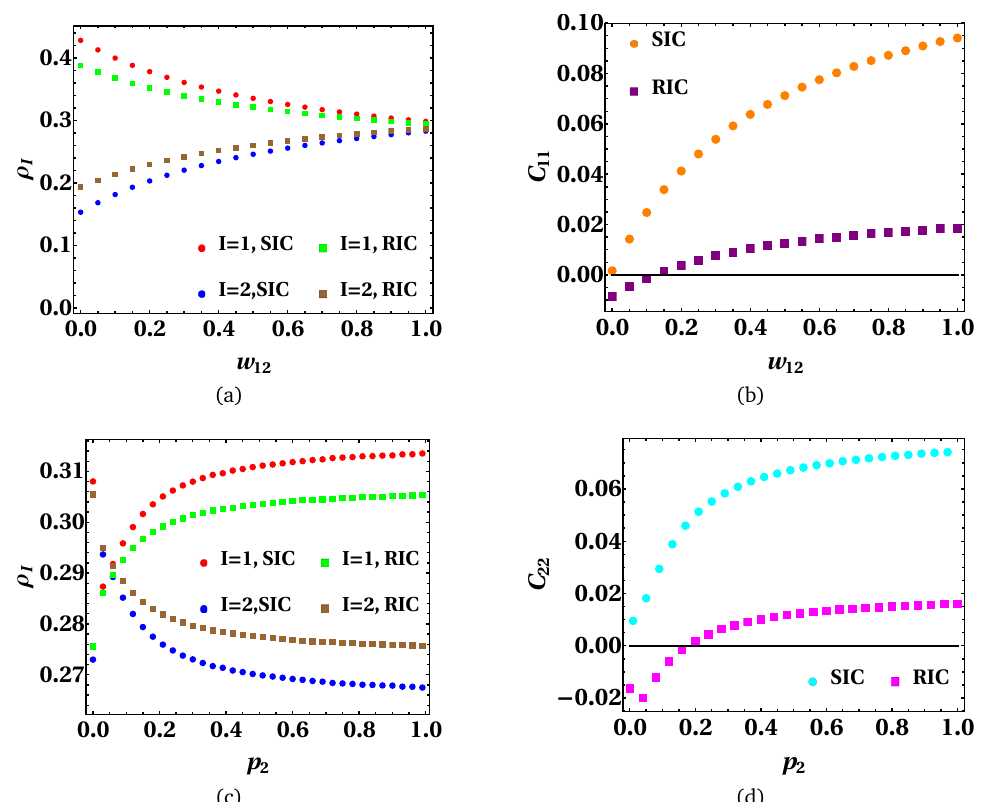
Figure 9: The set of figures exhibits the dependence of steady state values of observables on the choice of initial configuration. We observe clear devi- ations between SIC (denoted by circles) and RIC (denoted by rectangles) in (a)-(d) and the amount of deviation in each figure changes with the varia- tion of input parameter. The common set of parameters used for (a)-(d) are = 0.3, ε = 0.1, ρ = 0.216, ρ = 0.203, ρ ( 0 ) = 0.321, ρ ( 0 ) = 0.260. L = 10 3 , p + 1 0 1 2 = 1.0, w = 0.6 and for (c), (d) are The other parameters for (a), (b) are p 2 21 = 0.5, w = 0.4. The ensemble averages are done over 10 5 w 12 21